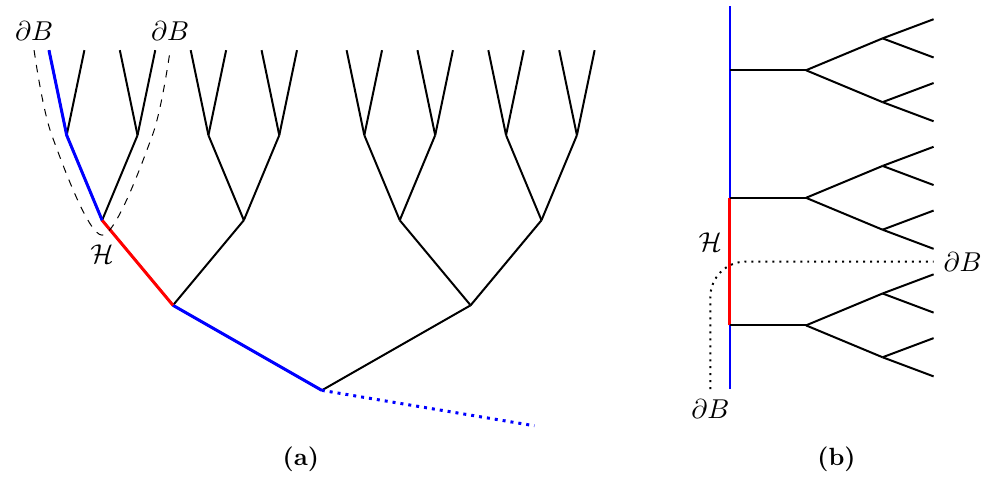
Figure 3. (a) The Hilbert space associated to @B . (b) A representation of the Bruhat-Tits tree H adapted to the p -adic cylinder, corresponding to radial quantization. The central trunk is the bulk line between the ball’s center and , while the boundary of each branching from the central trunk 1 x is a sphere ( = j j